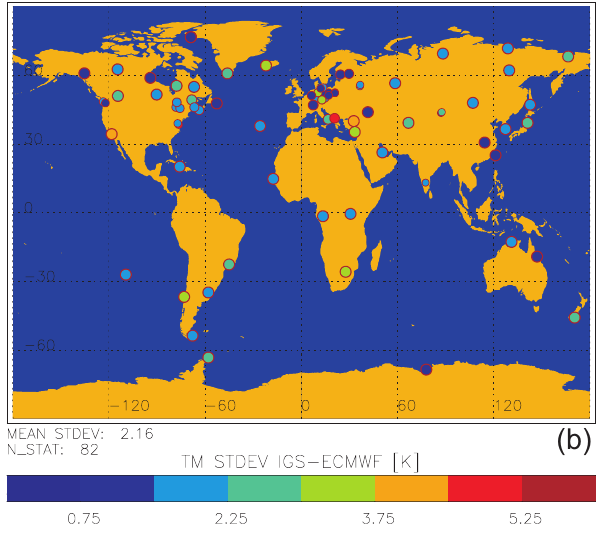
Fig. 7. Same as Fig. 6 but for mean temperature T m